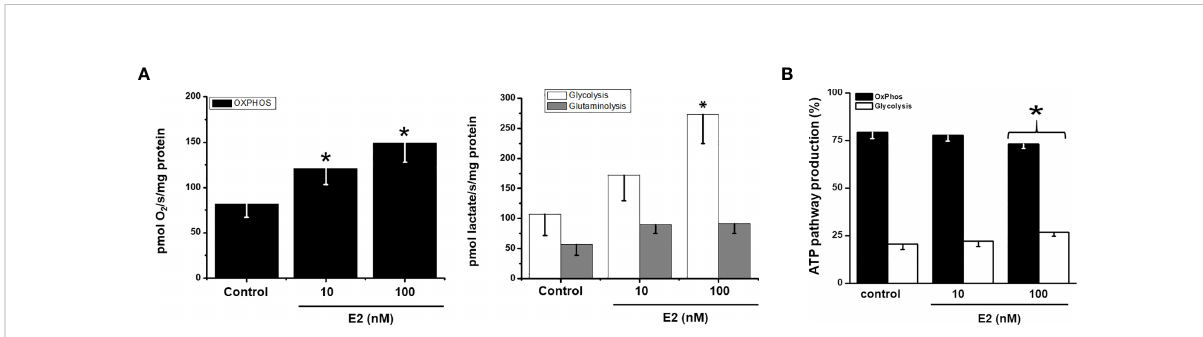
FIGURE 4 Effect of E2 on (A) energy metabolism fl uxes and (B) ATP supply from glycolysis and OxPhos in MCF7 MCTS For OxPhos, fl ux represents the rate of oligomycin-sensitive oxygen consumption; for glycolysis, fl ux represents the rate of 2DG-sensitive lactate production; for glutaminolysis, fl ux represents the rate of 2DG-resistant lactate production. For ATP supply from OxPhos an ATP/O ratio of 2.5 (28), or P»/O2 ratio of 5 (22, 24), was used; for ATP supply from glycolysis it was assumed a stoichiometry of 1 mol of ATP produced per 1 mol of lactate formed. Data shown represent the mean ± S.D. of at least three different preparations. * P <0.05 vs. control (non-treated